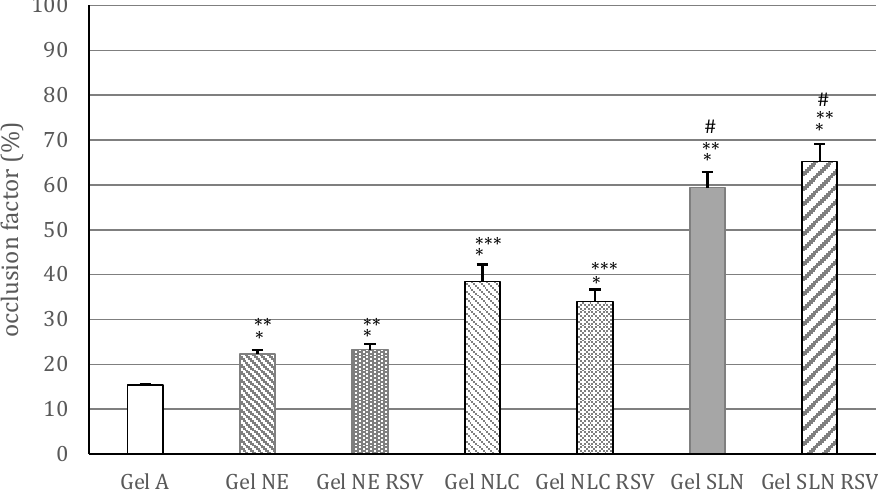
Figure 4. Occlusion factor (%) of gels without lipid nanocarriers (gel A), containing unloaded NE (gel NE), NLC6 (gel NLC), SLN (gel SLN) or 1% w / w RSV loaded NE (gel NE RSV), NLC6 (gel NLC RSV) and SLN (gel SLN RSV). Statistical analysis for the comparison: * p < 0.05 vs. gel A (control); ** p < 0.05 vs. all other gels; *** p < 0.05 vs. all other gels; # p < 0.05 vs. all other gels; p > 0.05 for the comparisons: gel NE vs. gel NE RSV, gel NLC vs. gel NLC RSV, gel SLN vs. gel SLN RSV.